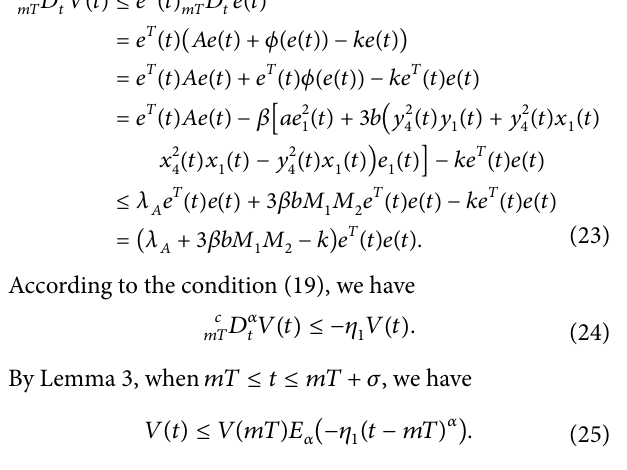
, ; (b) , ; (c) , ; (d) , 𝑥 1 (𝑡) 𝑦 1 (𝑡) 𝑥 2 (𝑡) 𝑦 2 (𝑡) 𝑥 3 (𝑡) 𝑦 3 (𝑡) 𝑥 4 (𝑡) 𝑦 4 (𝑡)